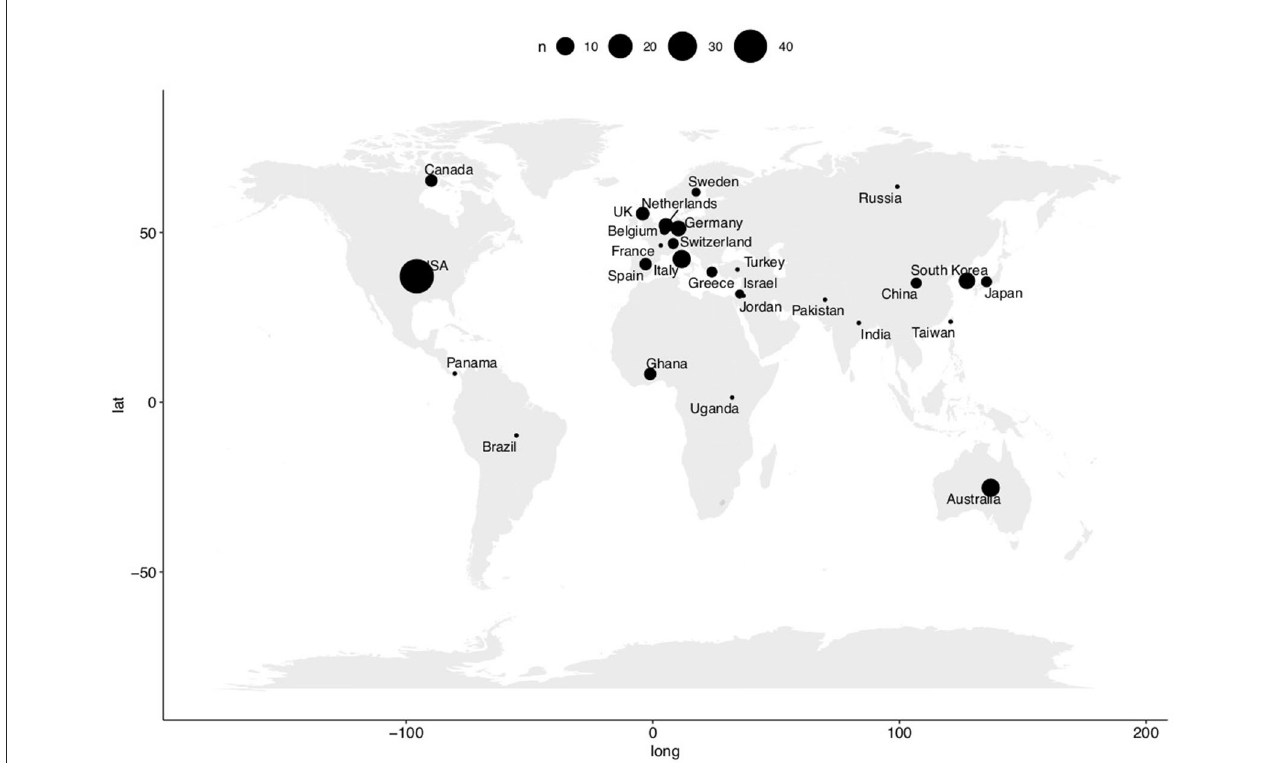
FIGURE1 Breakdown of the included studies by country. The size of the bubbles is proportional to the number of studies performed in the countries.